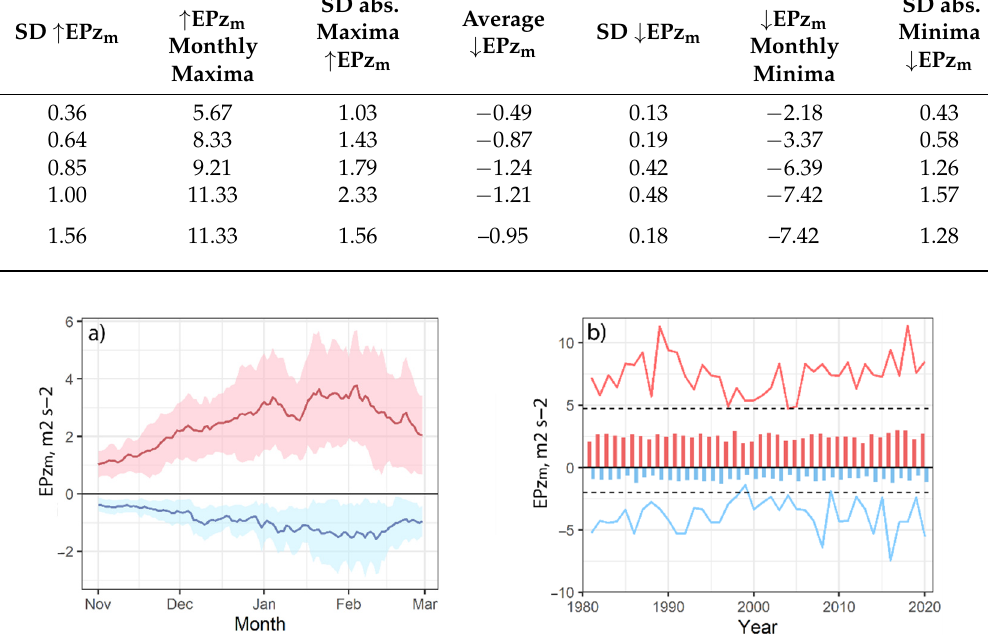
Figure 1. Climatology of EPz m WAF; ( a ) daily variability of upward EPz m (red line) and downward EPz m (blue line) averaged over 1981–2020, where shadowed ribbons show the standard deviation for each day; ( b ) average NDJF values of upward EPz m (red bars), downward EPz m (blue bars), and absolute seasonal EPz m maxima (red line) and minima (blue line) over 1981–2020. The dashed horizontal lines accordingly show the 90th and 10th percentiles of ↑ EPz m and ↓ EPz m . The average EPz m values for the entire period of November–February are 2.4 m 2 s −